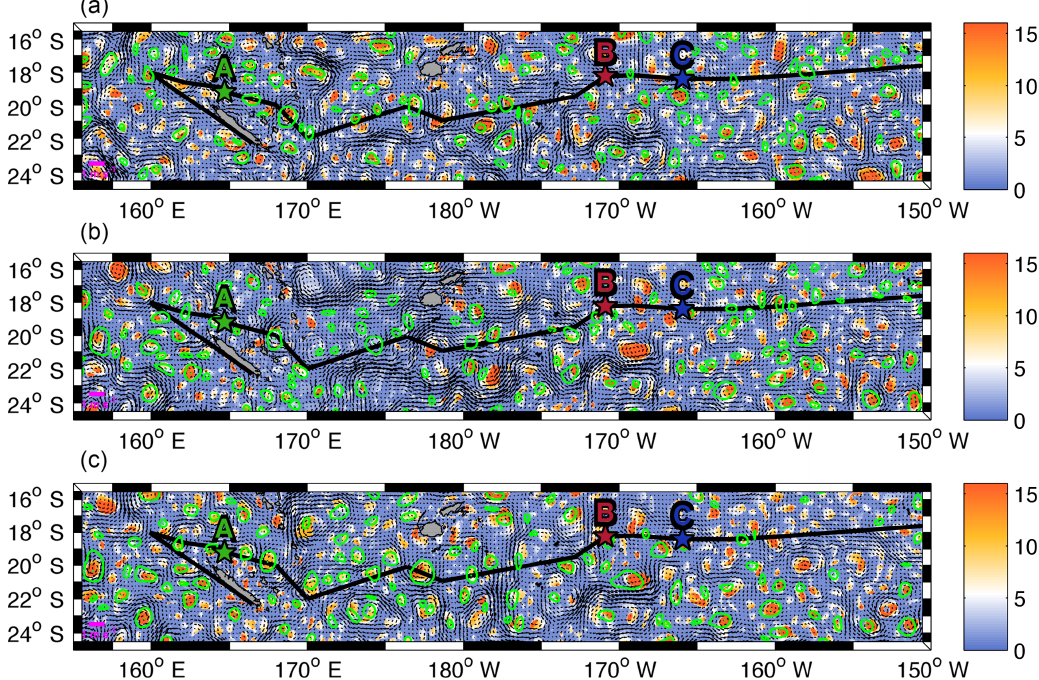
Figure A3. Particle retention time (days, colour bar) and velocity field (ms − 1 ) derived from the geostrophy, Ekman and cyclogeostrophy included product for the first day of LDA (25 February, a ), LDB (15 March, b ) and LDC (23 March, c ). Contours of LAVD-detected structures are drawn in green. The centre of the each structure is marked with a green point. The ship track and locations of OUTPACE LD stations are indicated with the black line and coloured stars as in Fig.